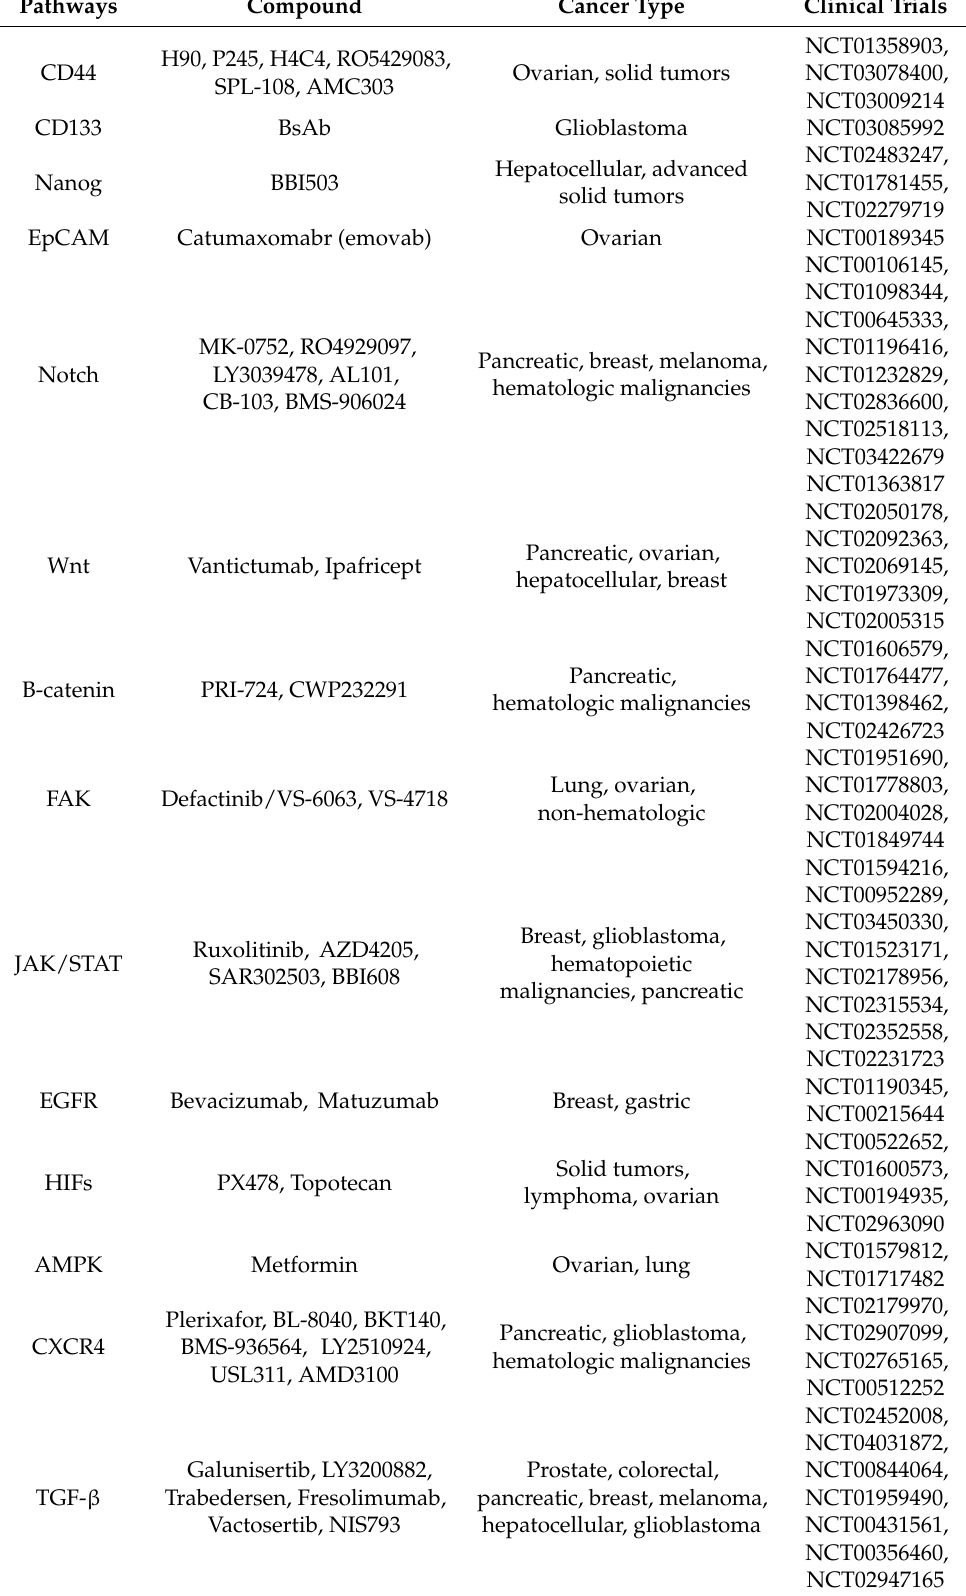
Table 3. Compounds that act against CSC-related